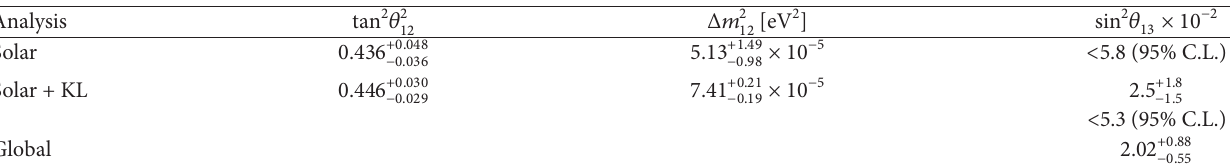
was minimized with respect to all other parameters. The global analysis includes Solar + KL + ATM + LBL +